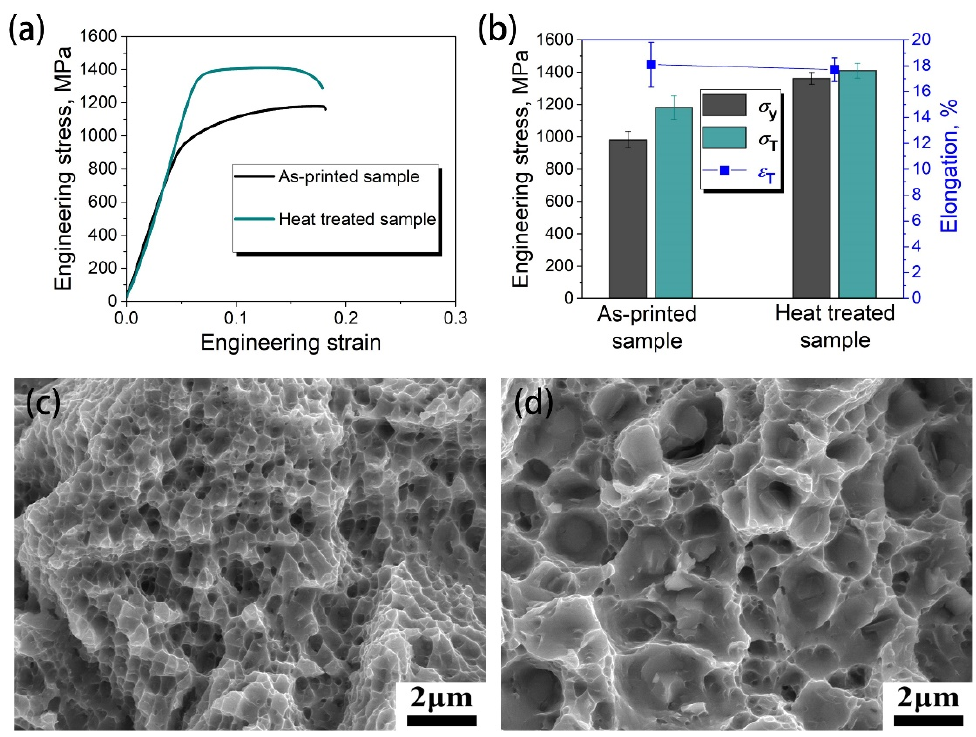
Figure 6. The ( a , b ) tensile properties and ( c , d ) SEM fracture surfaces of the as-printed and heat-treated nickel-based superalloy specimens.